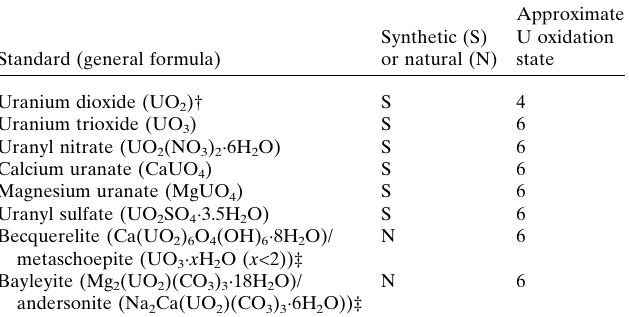
Table 2 U-bearing ceramic and mineral phases measured by U L III -edge XAS.